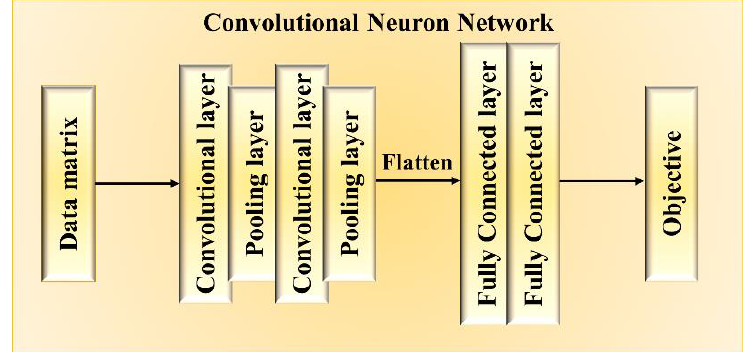
Figure 5. Construction of the convolutional neural network